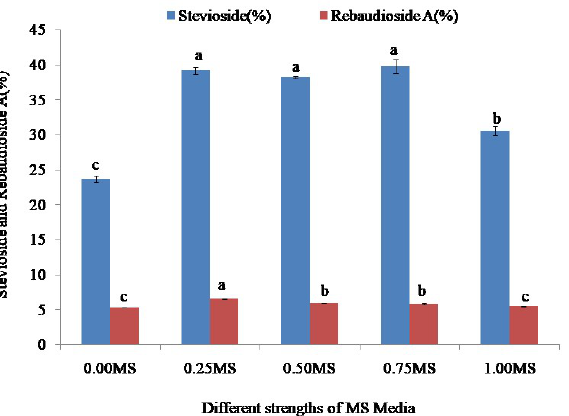
Figure 8. Stevioside and rebaudioside A content in the leaves of stevia rooted on different strengths (0.00, 0.25, 0.50, 0.75, and 1.00) of MS media. Bars denote the mean of three replications per treatment ± SE (standard error). Mean values with the same letters are not significantly different based on the Student’s t -test at p = 0.05.